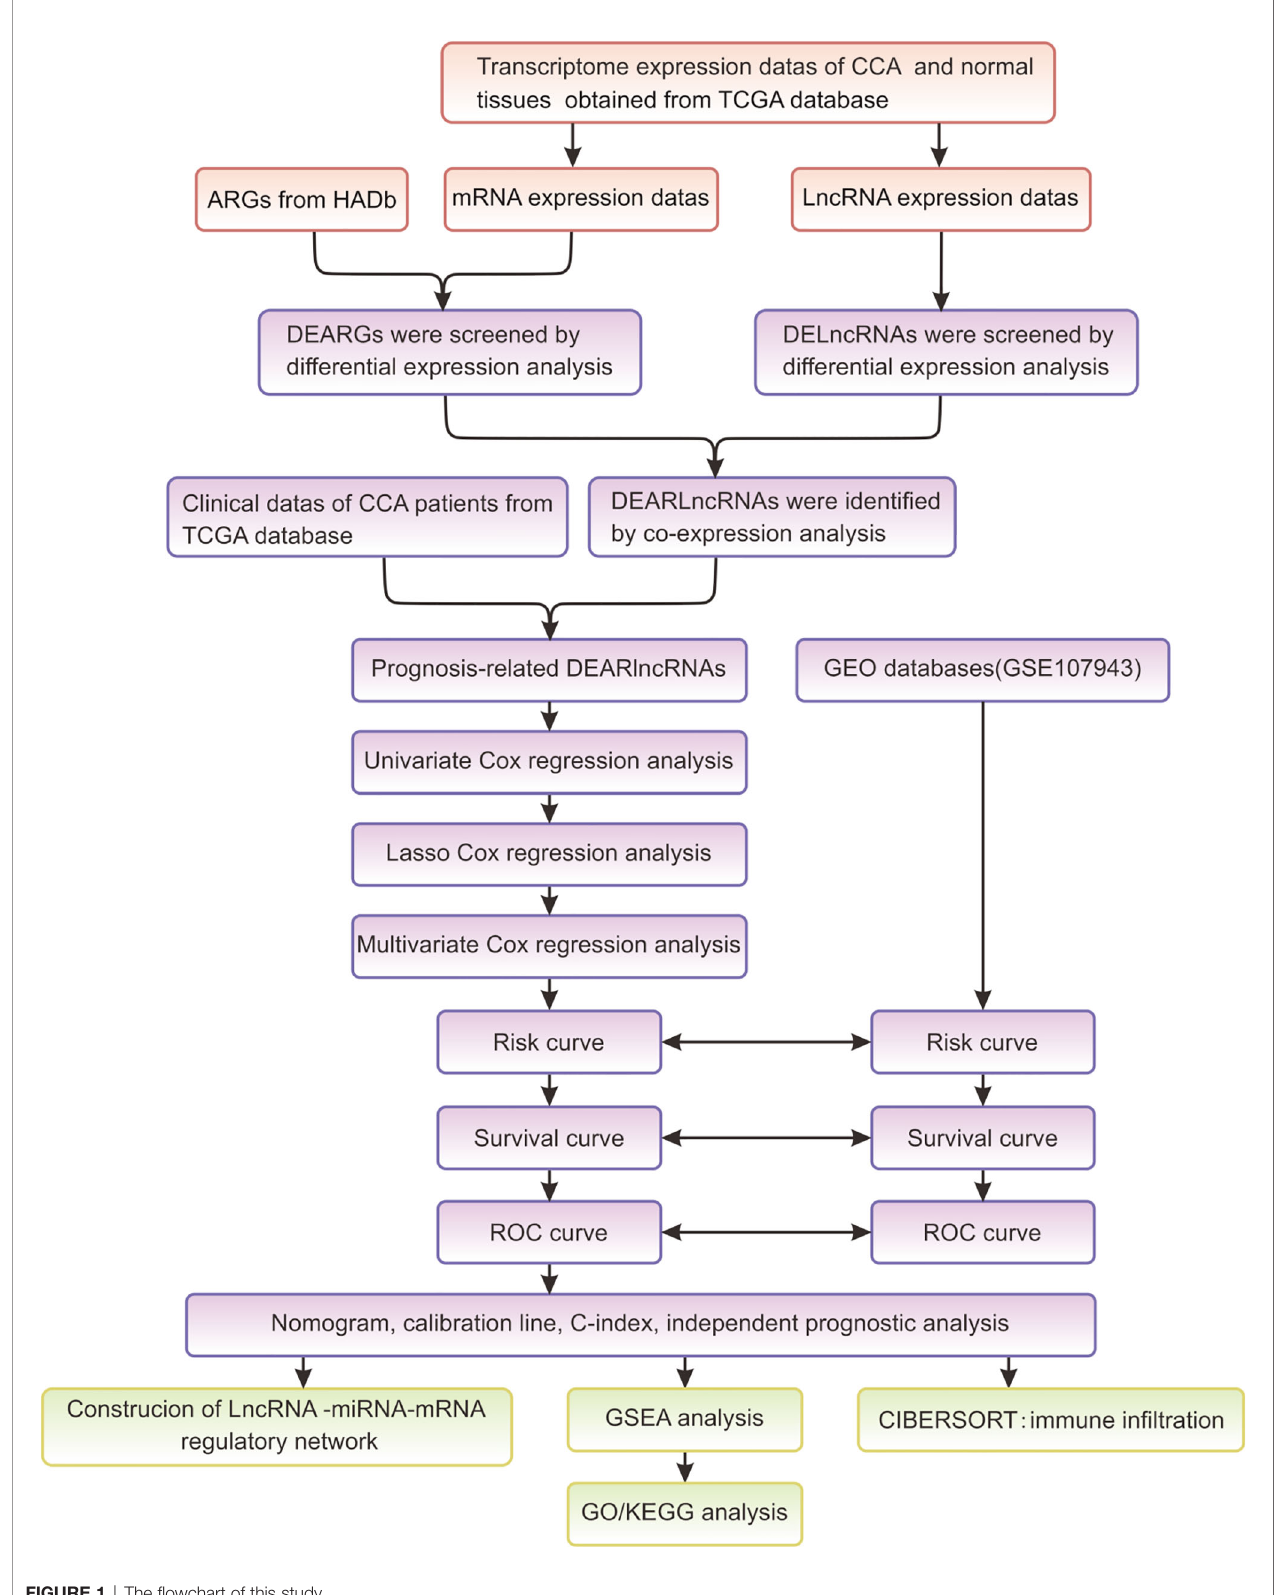
FIGURE 1 | The fl owchart of this